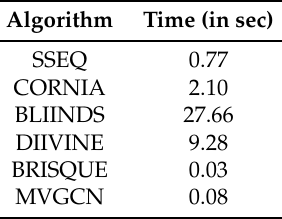
Table 6. Comparison of median time taken per image to extract features by different NR IQA algorithms on a 4-GHz quad-core processor with 32 GBs of RAM. The median is computed over all distorted images from the LIVE